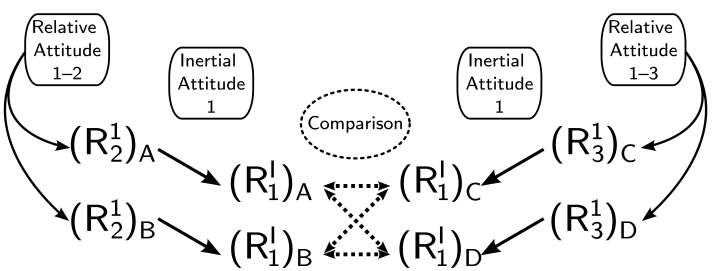
Figure 2. Disambiguation